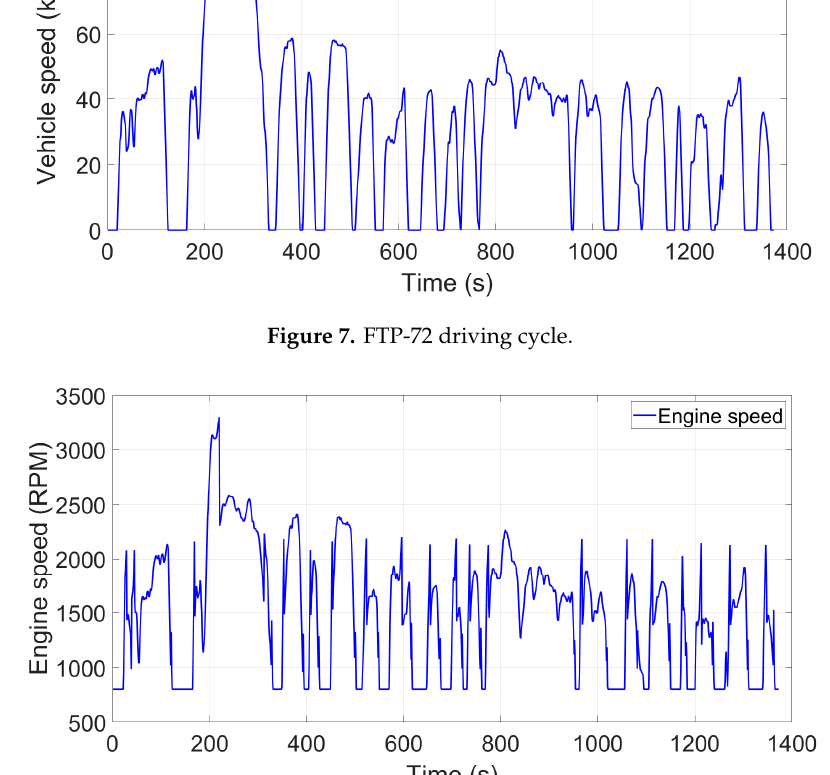
Figure 8. FTP-72 transient engine speed profile.